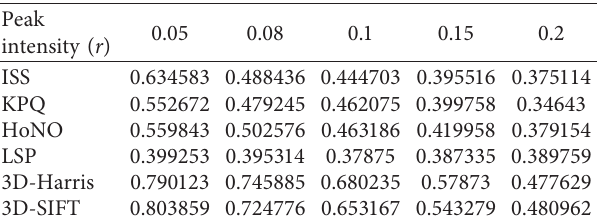
Table 5: Gaussian noise repetition rate r detection algorithm on the Kinect data set.